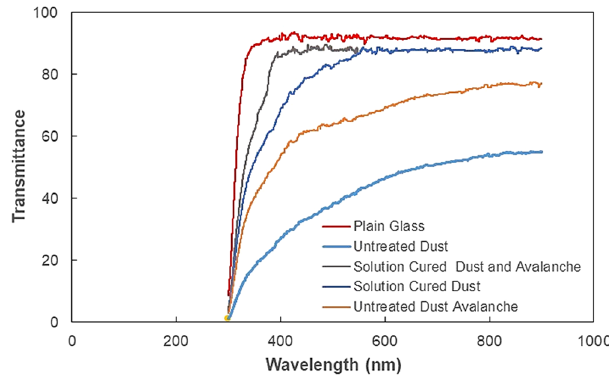
Figure 12. Optical transmittance of dust mitigated glass